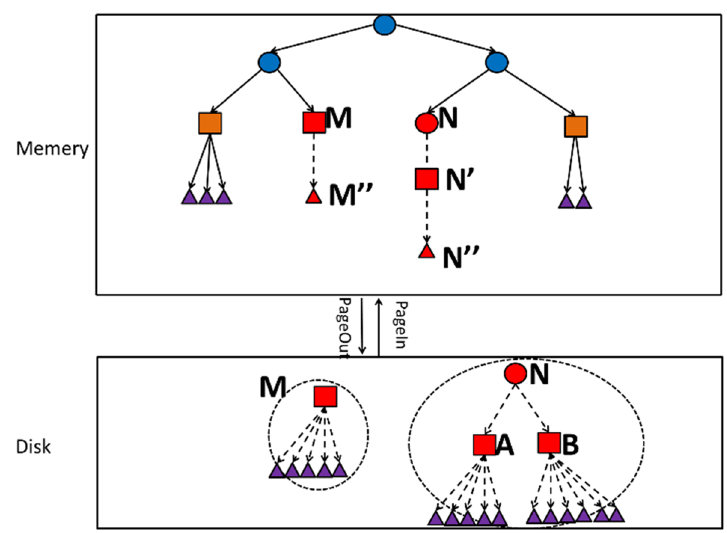
Fig. 9 The instance of pageIn and pageOut. It is a whole SKDTree in the memery, and there are multiple summarizedsubstrees in the